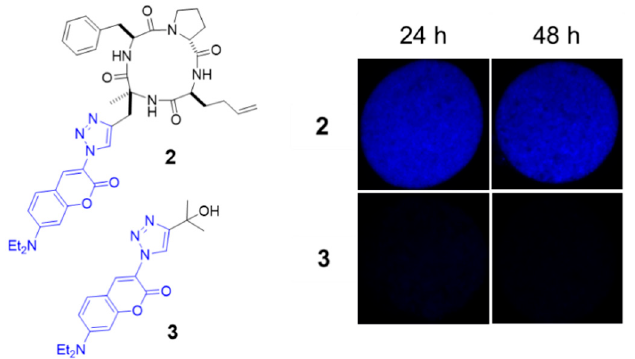
Figure 2. Comparison of cyst penetration observed by microscopy between the fluorochrome coupled with the cyclic tetrapeptide (compound 2 ) and the dye alone (compound 3 ); Ex vivo T. gondii cysts (PRU strain) incubated with the compounds 2 or 3 at concentration = 1 µM, 37 °C, exposure time = 100 ms.